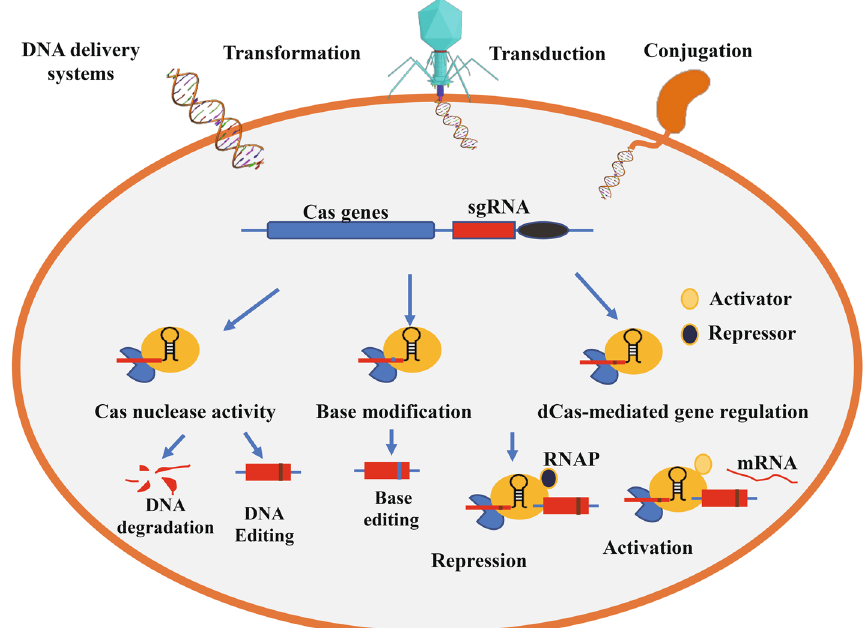
Fig. 3 Genome editing by CRISPR-Cas system. CRISPR-Cas delivery can be made via transformation, transduction or conjugation. The outcome can be deleterious cell death due to massive DNA degradation or, the DNA break may be repaired while introducing some mutations. Catalytic domain inactive dCas9 can also silence a target gene by interfering with RNA polymerase